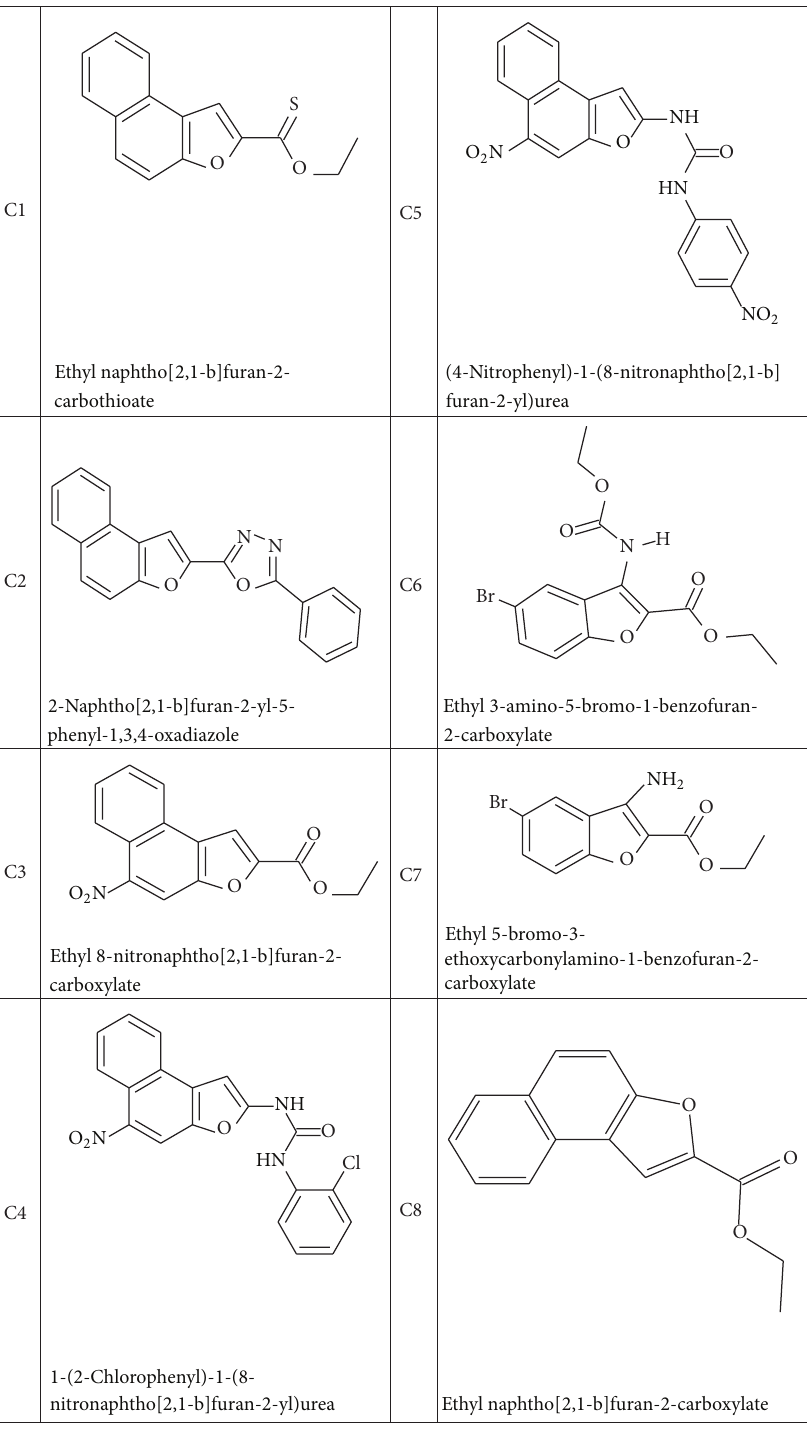
with Ala 44, Met 67, and Ala 74-75 and aiding the ligand to be in the hydrophobic pocket and the remaining part of the ligand to be in the polar region of the protein. Figure 10 represents the interaction of C7 in the active site of NarL after molecular dynamic